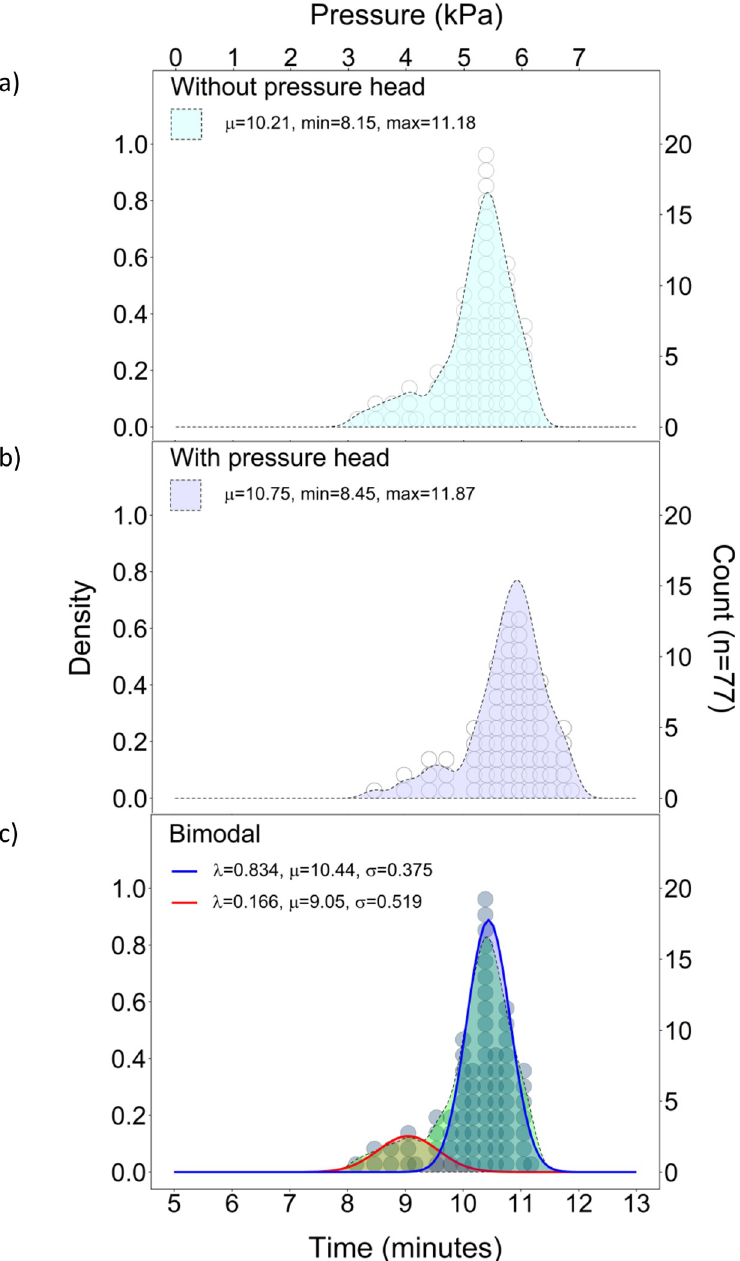
Fig 3. Distribution of failure times: a) without pressure head, b) with pressure head, and c)